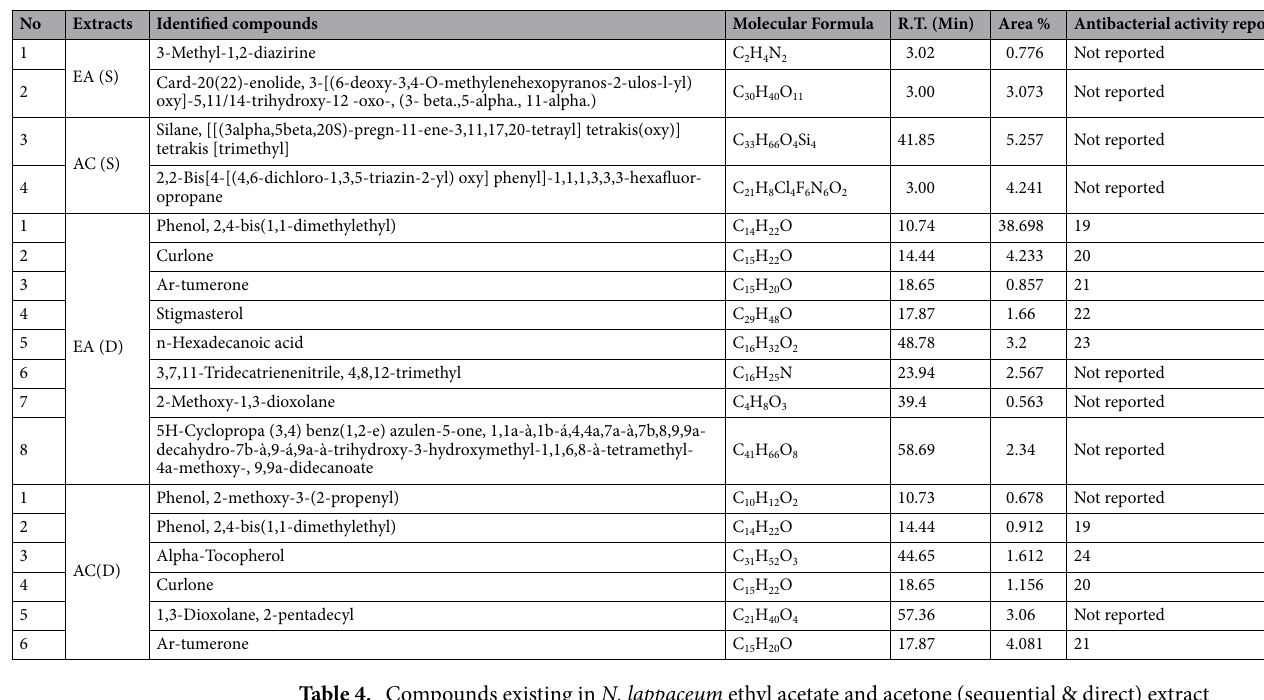
Table 4. Compounds existing in N. lappaceum ethyl acetate and acetone (sequential & direct) extract identified by GC–MS analysis. EA(S): Ethyl acetate sequential; AC(S): Acetone Sequential; EA(D): Ethyl acetate direct; AC(D): Acetone direct.